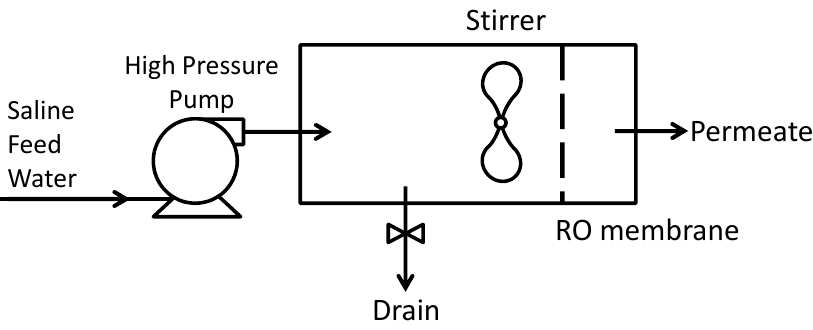
Figure 10. The concept of closed circuit RO operation.